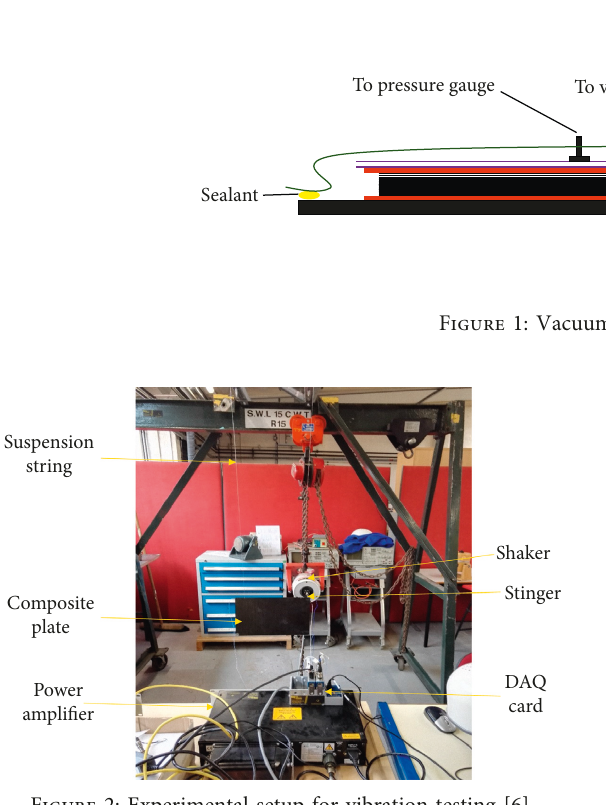
Figure 2: Experimental setup for vibration testing [6].